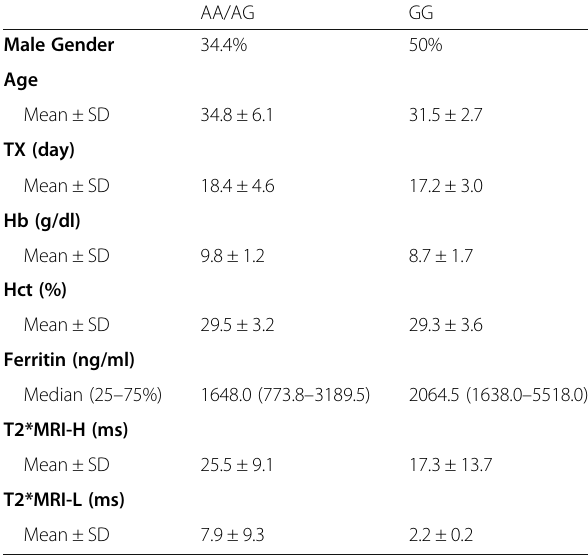
Table 2 Imaging and laboratory data of the patients based on the genotype of c.-582A > G